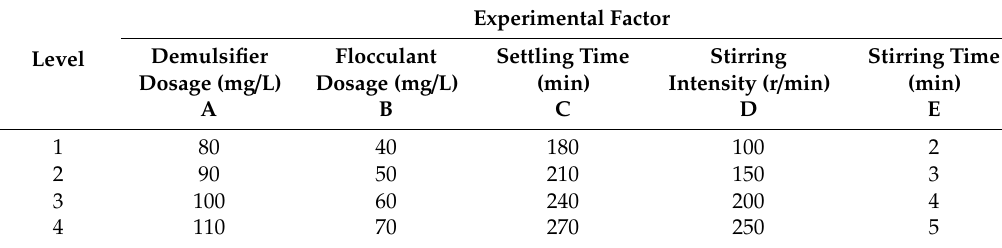
Table 6. Experimental factors of demulsification–flocculation compound system.